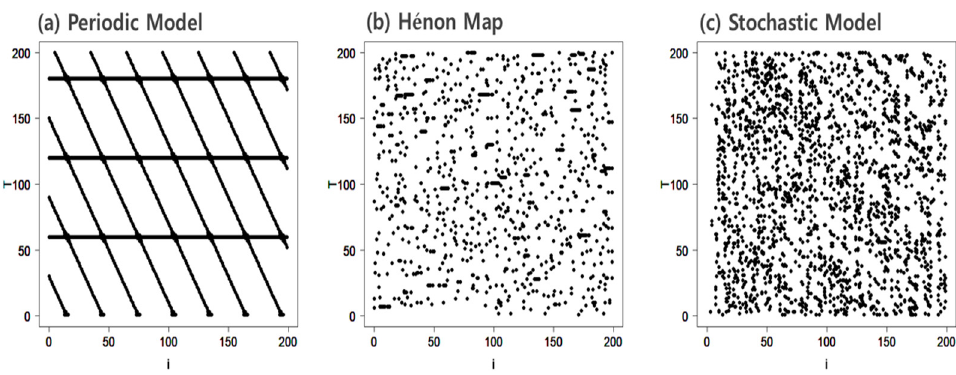
Figure 10. Close returns plots (CRPs) for ( a ) the periodic model (x ( t ) = sin ( 2 π t ) ), ( b ) the Hénon map (x ( t ) = 1 + x ( t − 1 ) − 1.4x ( t ) 2 ), and ( c ) the stochastic model (x ( t ) = 50 + 0.8 ( x ( t − 1 ) 50 ) + (cid:15) ( t )) when r = 0.01.